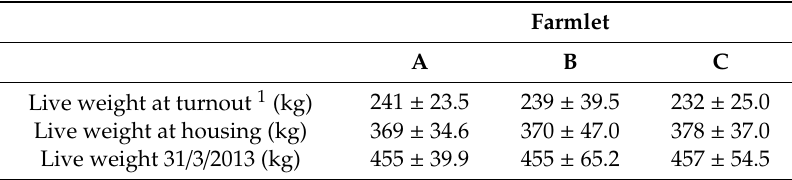
Table 6. Live weights for cattle born in summer 2011 during the 2012 grazing season (5 heads per farmlet). Farmlet A B C Live weight at turnout 1